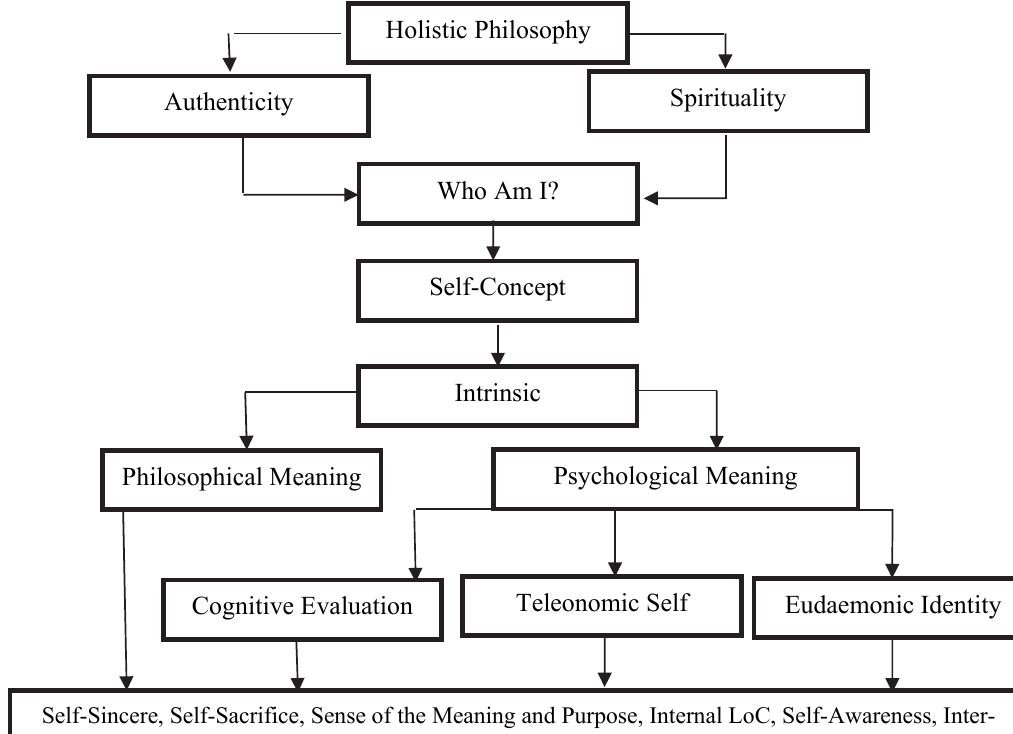
Fig. 1. Deductive Approach to Intrinsic Leadership Scale